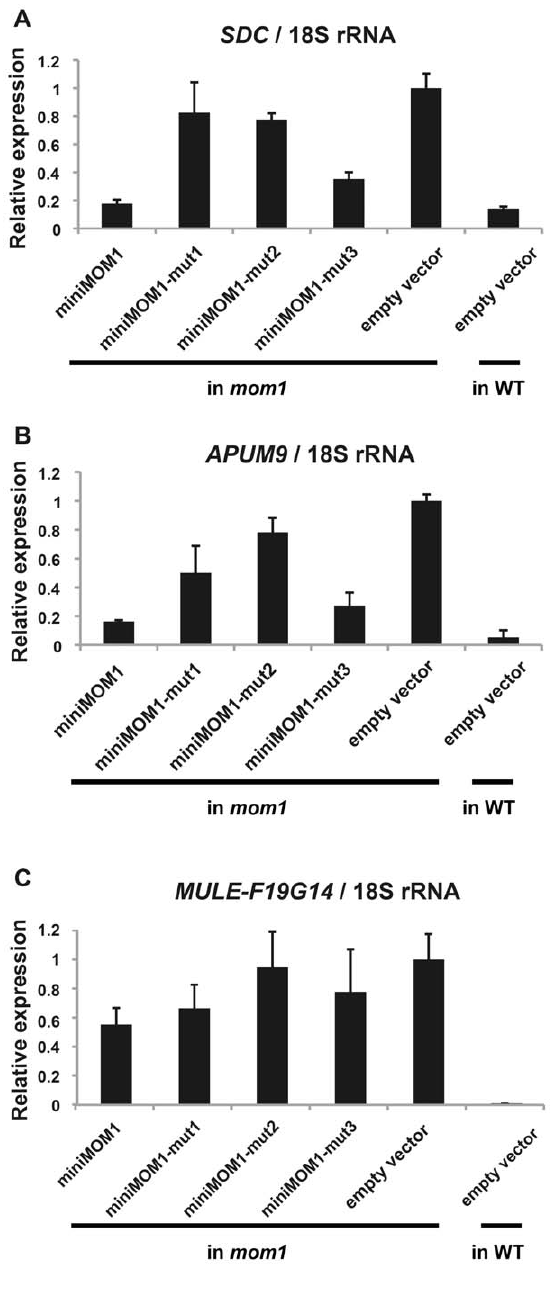
Figure 6. Multimerization of CMM2 domains is crucial for TGS activity at various chromosomal loci. Relative levels of mRNAs in T2 plants of various MOM1 target loci determined by quantitative RT- PCR and normalized to 18S rRNA. These T2 plants were delivered from 3 independent T1 plants. The mean of ‘‘empty vector in mom1 ’’ was set to 1. Error bars represent S.E. calculated from 3 experimental sets of 40 to 50 plants each.